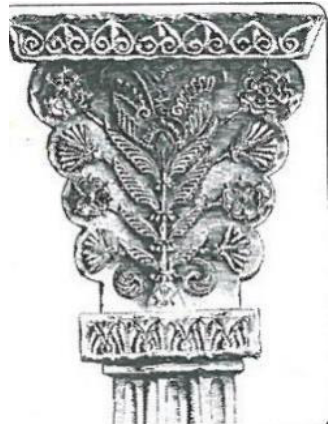
Figure 17. The relief of lions and a vase of lily flowers, Azadbakht,